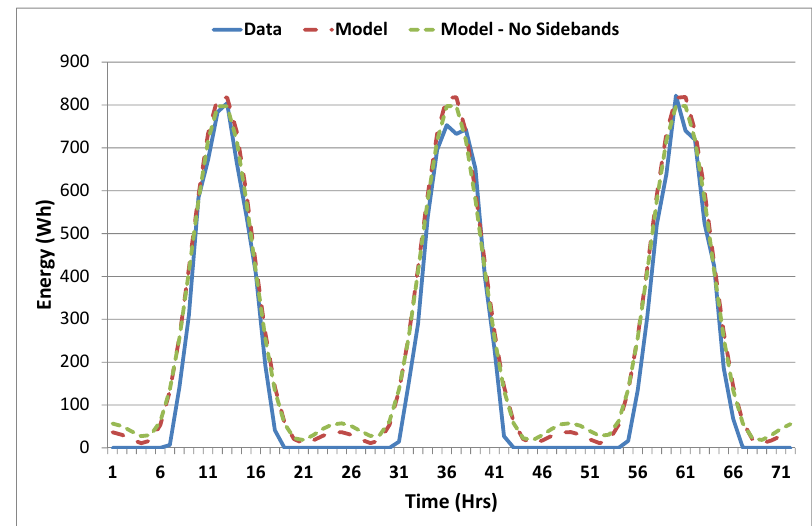
Figure 8. Comparison of Fourier series model with and without sidebands—summer in Desirade.